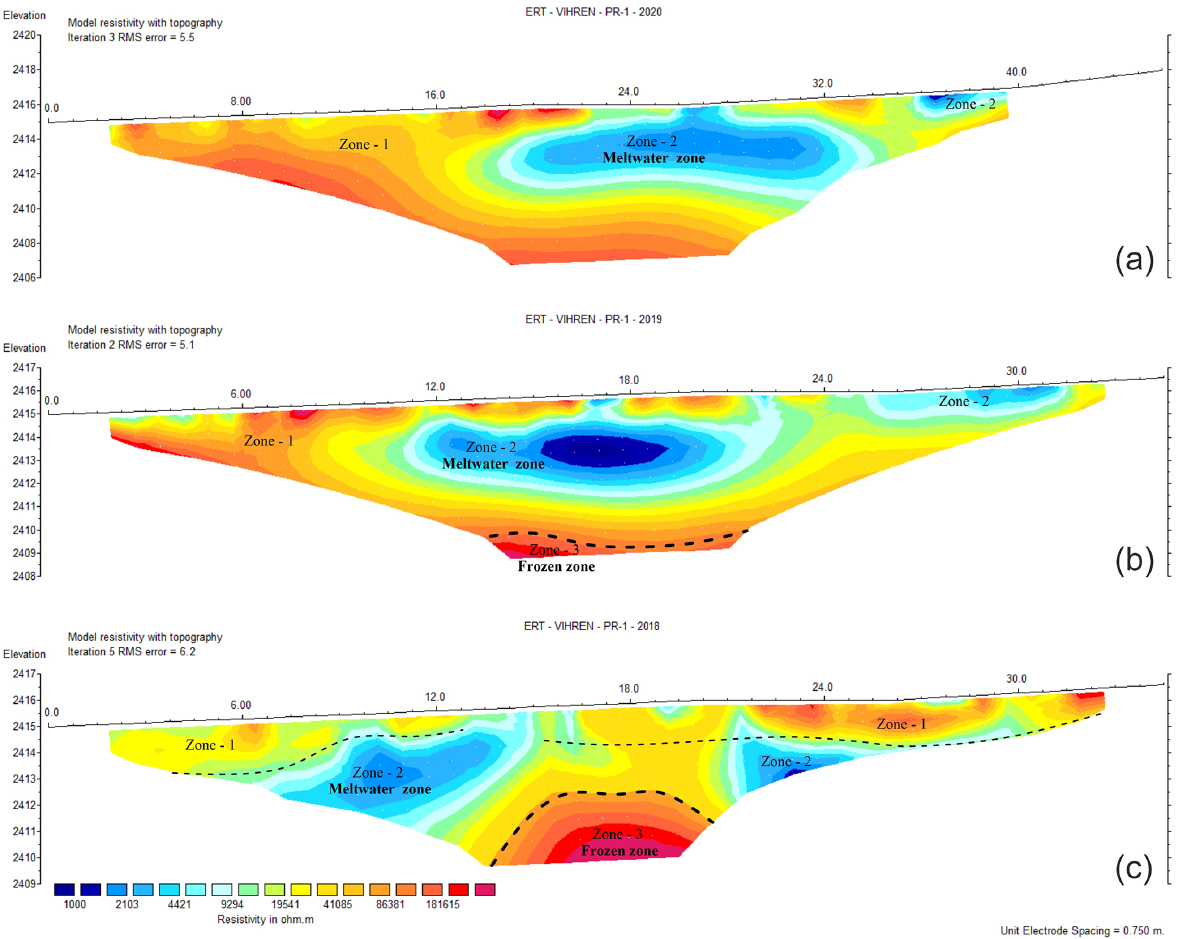
Figure 6. Electrical resistivity sections along ERT-1 obtained near the Snezhnika microglacier in 2020 (a) , 2019 (b) , and 2018 (c) . Blue color represents low resistivities, and red color indicates areas with very high